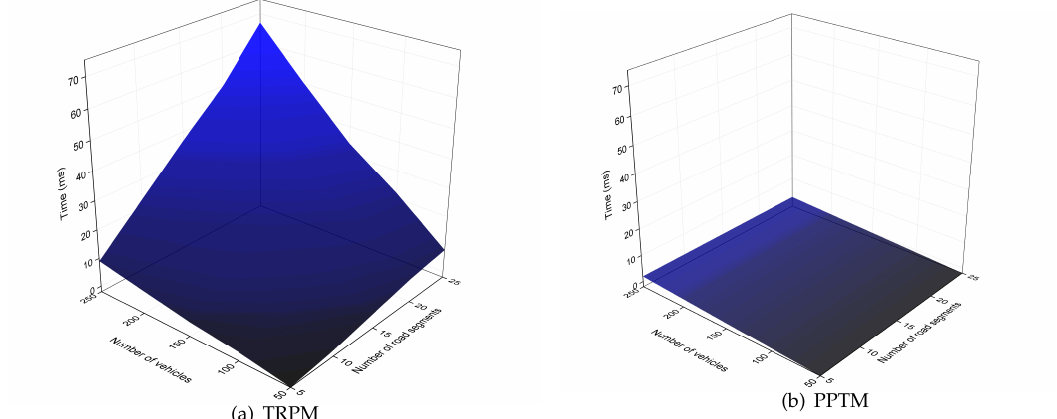
Figure 7. Computational costs with varying number of vehicles and road segments at the RSU